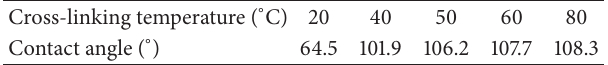
Table 1: Contact angle for water of PDMS-VTOS membranes synthesized at different temperatures.